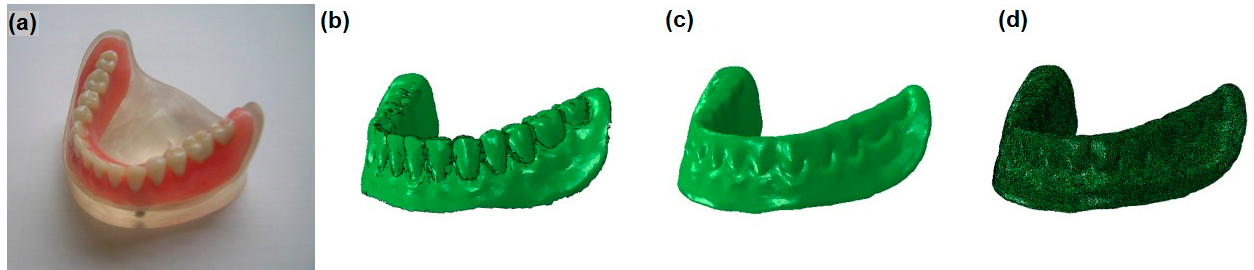
Figure 3. Steps of creating finite element mesh based on mandible cast: ( a ) input cast, ( b ) raw scanned data, ( c ) digitally processed model, ( d ) final finite element mesh.